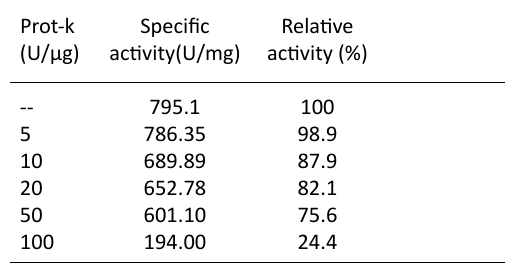
Table 6. Stability of esterase LKE-021 with proteinase -K